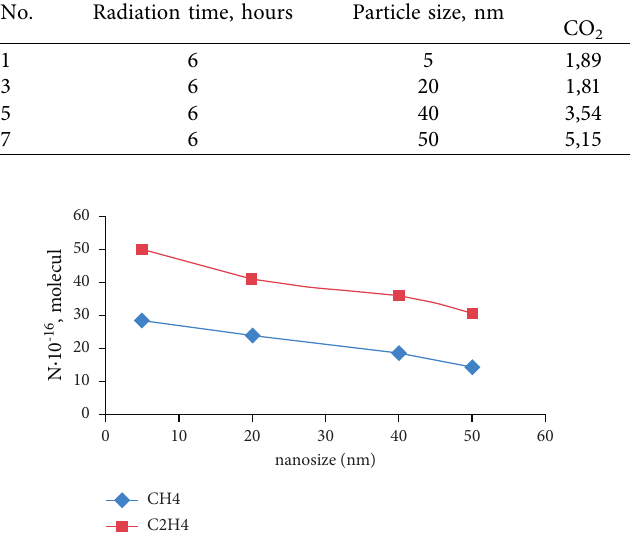
Table 1: The amount of gaseous products formed from a mixture of n-hexane and air at room temperature on the surface of nano-Al different sizes under the influence of radiation. No. Radiation time, hours Particle size, nm